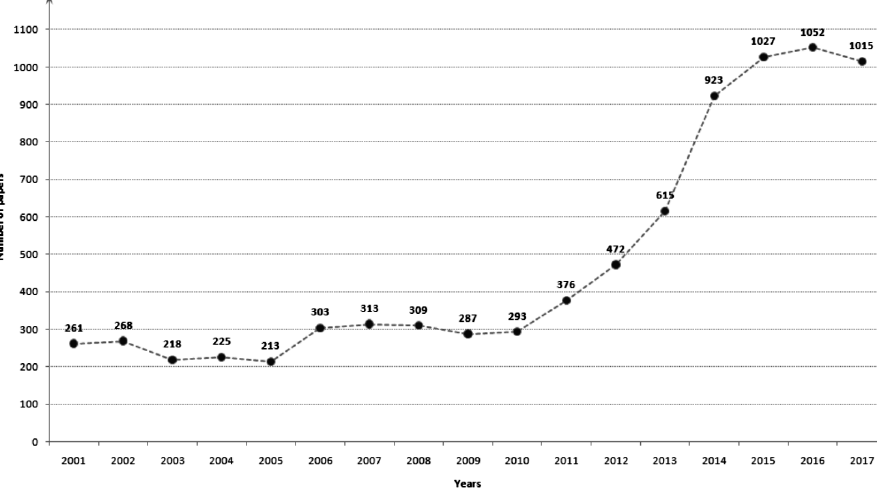
Figure 3. Changes in the number of publications in the field of quality management of medical services in the years 2001–2017 in the Scopus